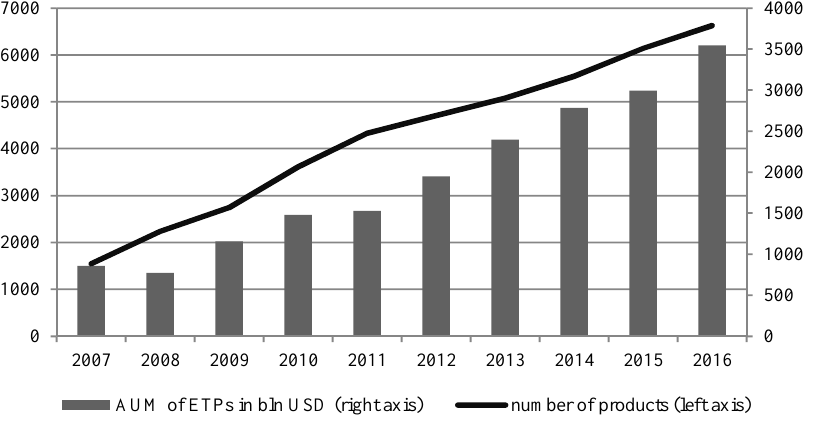
Figure 1. Global assets under management (AUM) and number of exchange- traded products between 2007 and